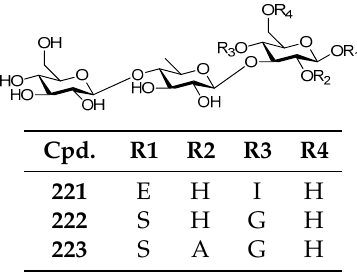
Figure 37. Structure of compound 220 . Molecules 2016 , 21 , 1402